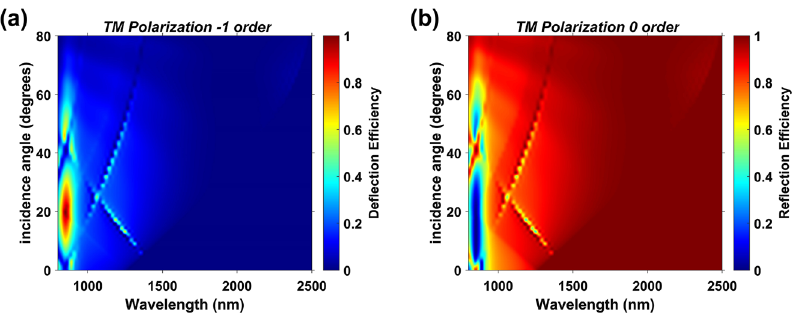
Figure 7: Contour plots of the simulated r m for (a) m = − 1 and (b) m = 0, case of